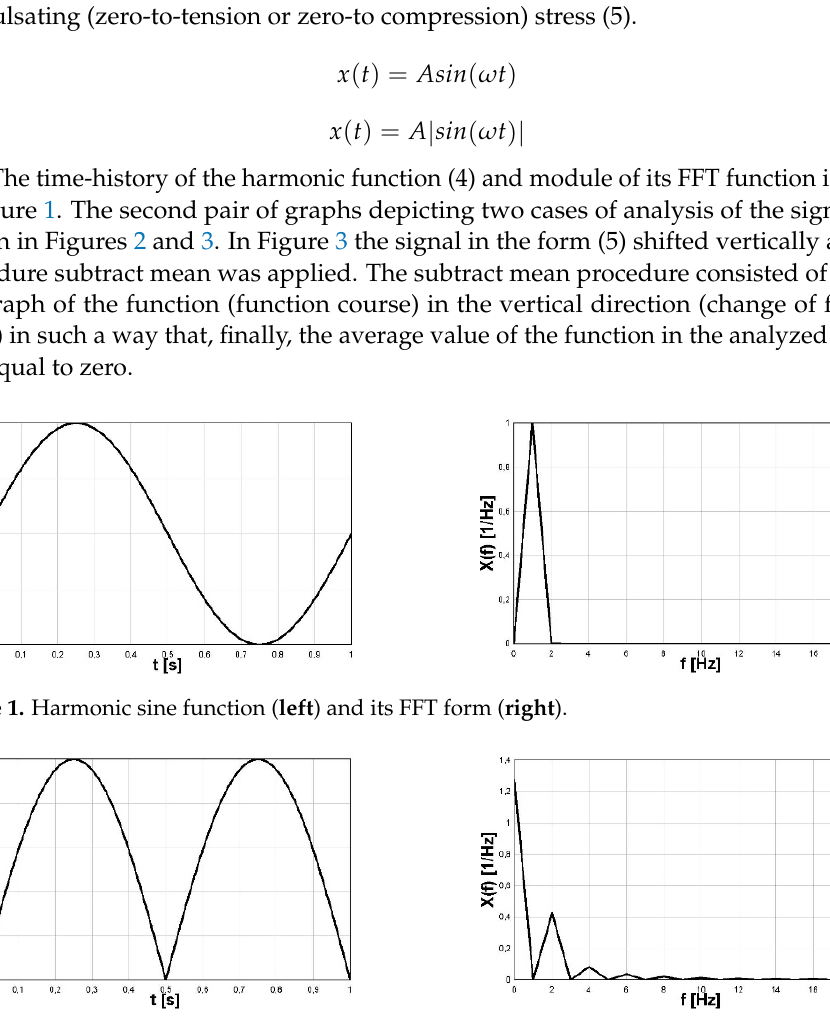
Figure 2. Absolute value of harmonic sine function ( left ) and its FFT form ( right ).